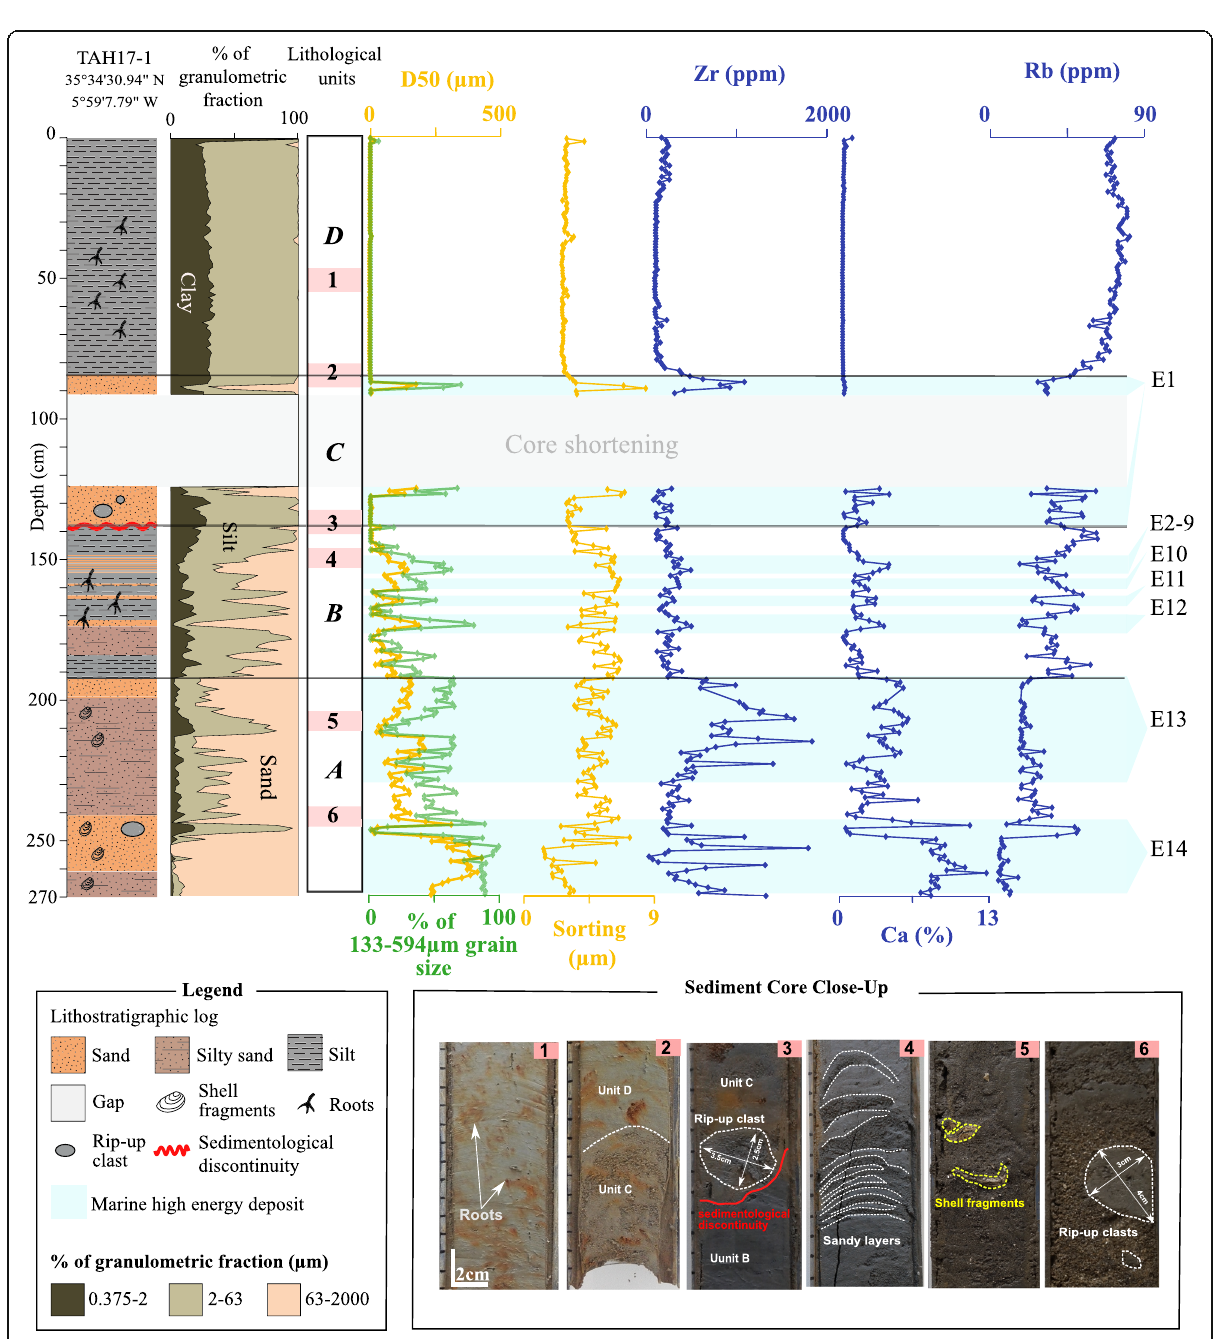
Fig. 3 Schematic log of the TAH17 – 1 core with grain size parameters (Cumulative grain size %, 133-594 μ m fraction, D50 and sorting) and geochemical profiles of Ca, Zr and